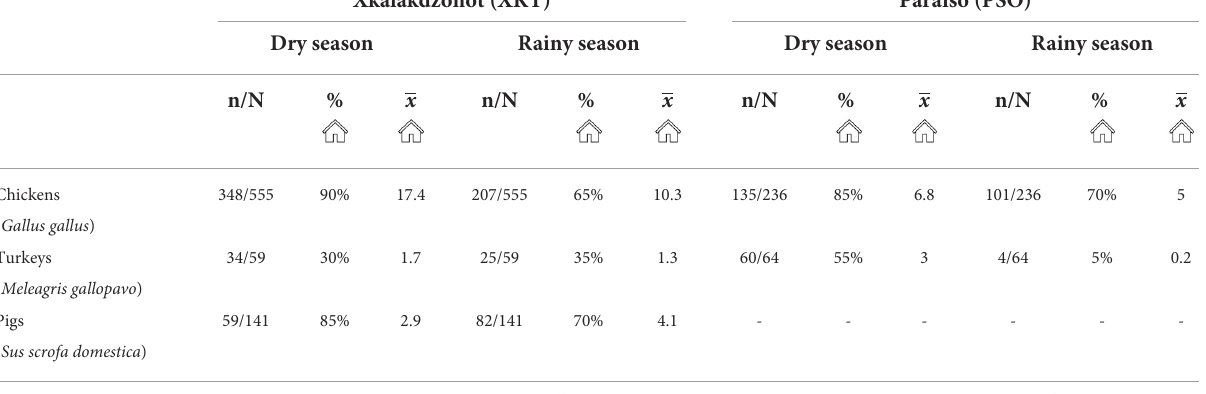
TABLE 2 Seasonal inventory of backyard animals, percentage of households that breeds them and average number of animals per household of two Mayan communities of Yucatan, Mexico. Xkalakdzonot (XKT) Paraiso (PSO)